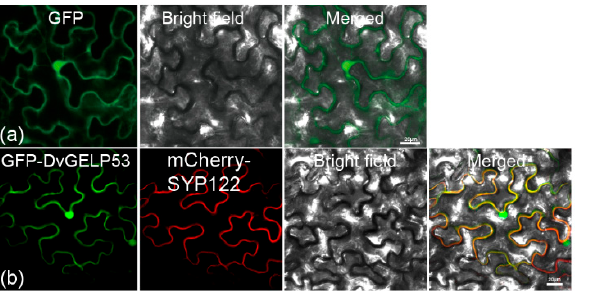
Figure 5. Subcellular localization of DvGELP53 in the epidermal cells of N. benthamiana . ( a ) GFP and ( b ) GFP-DvGELP53; GFP was used as the control. The localization of mCherry-SYP122 is shown in red, and the localization of GFP and its fusion proteins is shown in green. Scale bar = 20 µm.